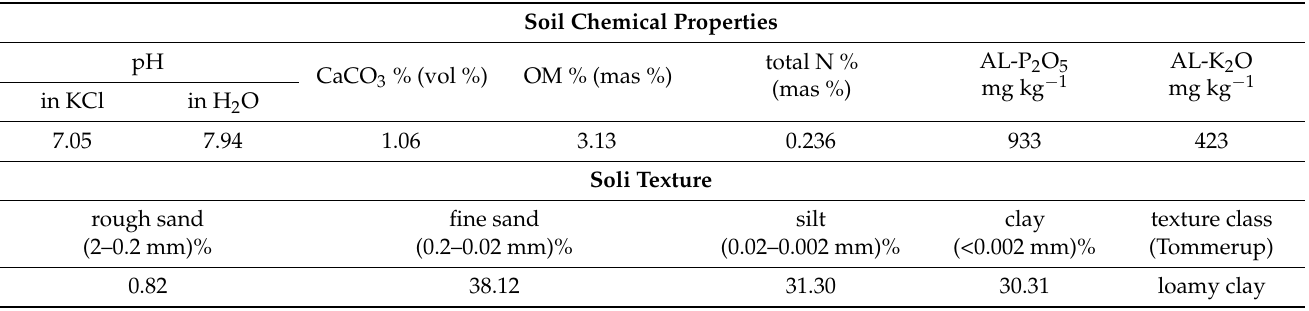
Table 1. Characteristics of the soil before the establishment of the